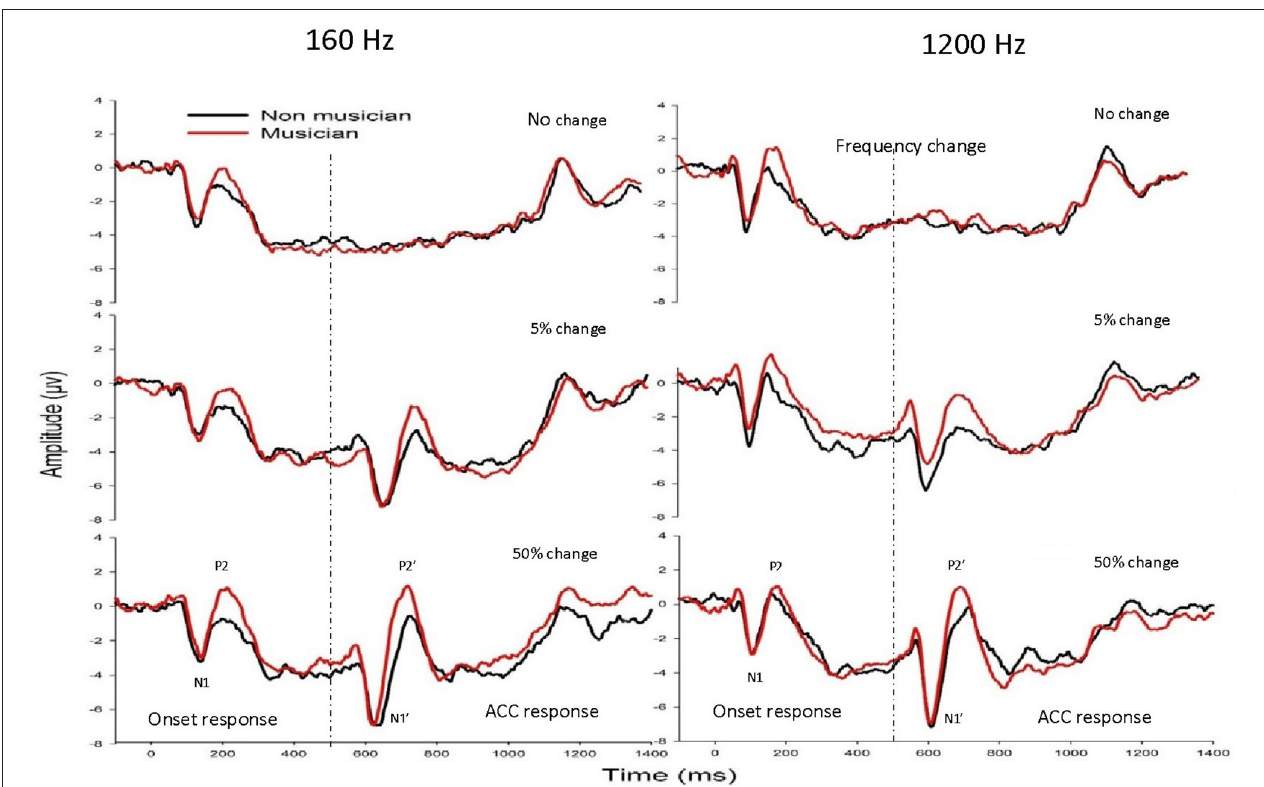
FIGURE 2 | The grand mean waveforms at electrode Cz from musicians (black traces) and non-musicians (red traces) for 160Hz (left panel) and 1200Hz (right panel) with a frequency change of 0% (upper subplots), 5% (middle subplots), and 50% (bottom subplots). The onset LAEP and the ACC are marked in one of these plots. There is no ACC when there is no frequency change.